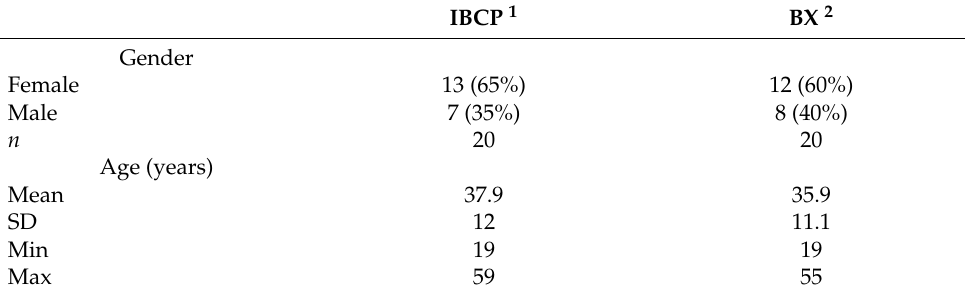
Table 1. Demographic data of participants.